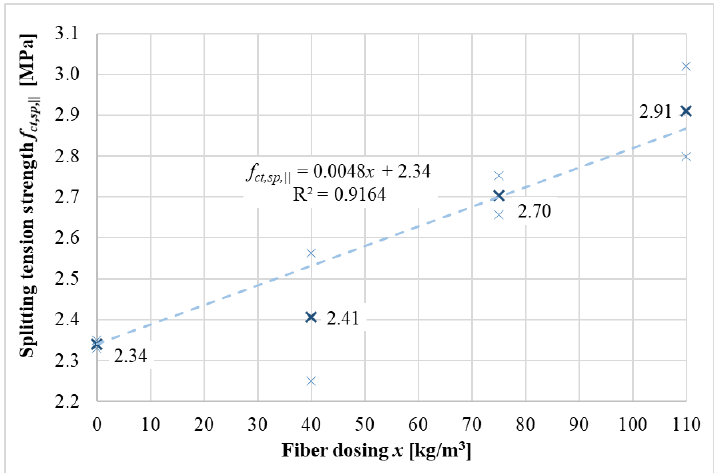
Figure 11. Regression analysis to determine the functional dependence of the splitting tensile strength parallel to the direction of filling f ct,sp, || on fiber dosage x .